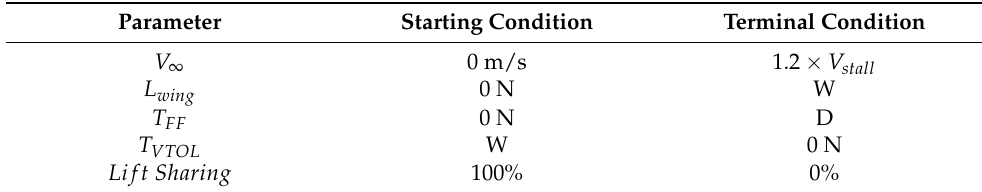
Table 6. Starting and terminal condition of the transition mode of multi-mode UAVs. Parameter